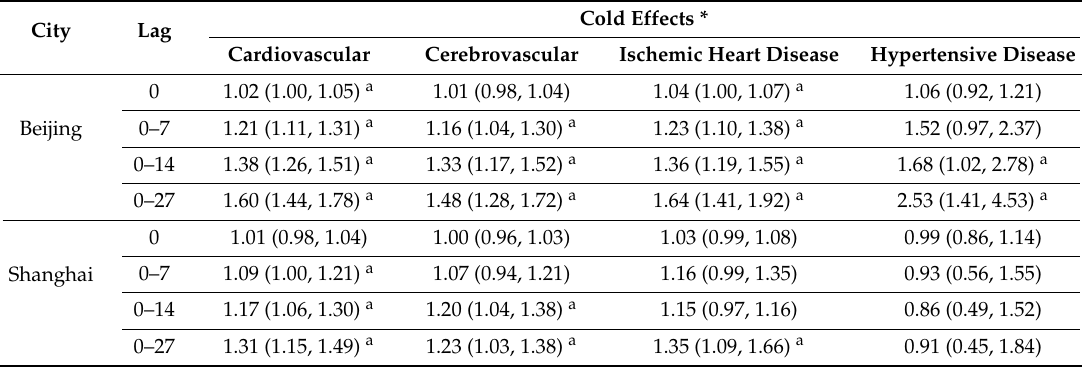
Table A3. The cumulative cold effects on cardiovascular disease, cerebrovascular disease, ischemic heart disease and hypertensive disease in Beijing and Shanghai, China. Cold Effects * City Lag Cardiovascular Cerebrovascular Ischemic Heart Disease Hypertensive Disease